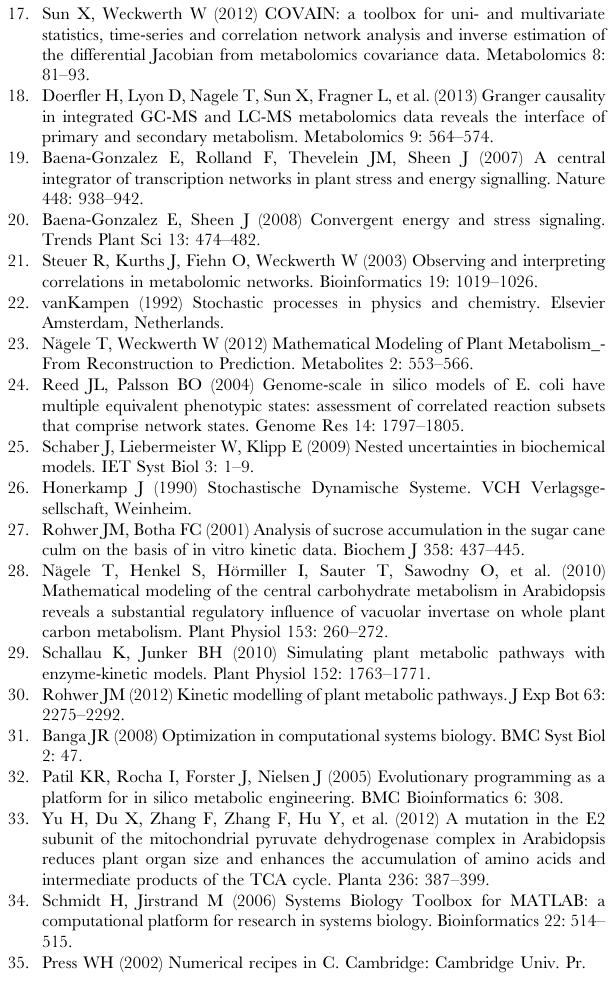
Figure S1 Interquartile distance of calculated Jacobian entries derived from n replicates. Each interquartile of samples under conditions of light (A) and extended night (B) was normalised to the interquartile distance of 10 replicates.